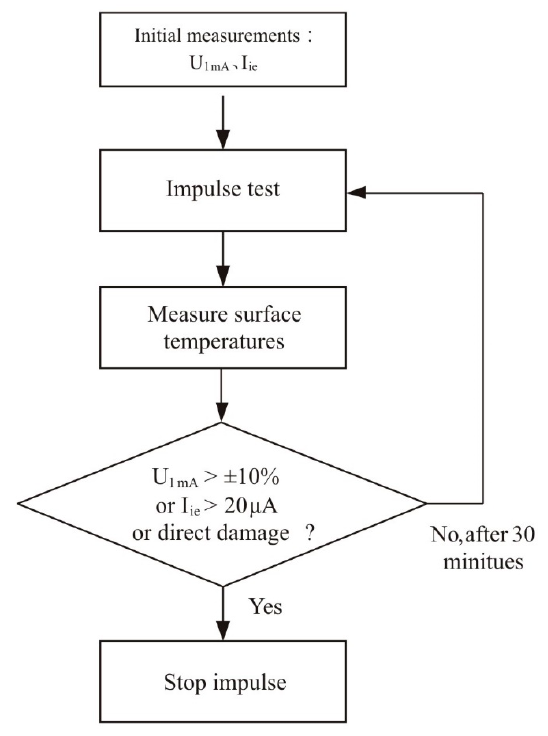
Figure 4. Flowchart of the experimental procedure.